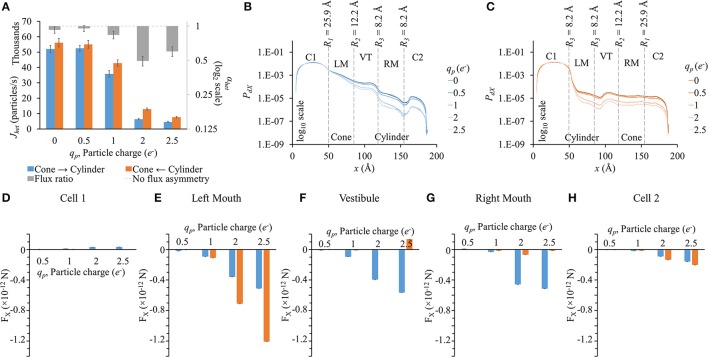
Role of particle charge on flux asymmetry in heterotypic pores. Simulation results in heterotypic pore with profile 25.9-12.2-8.2-8.2 with constant concentration gradient, 2 mV transjunctional voltage and rp = 4.9 Å. (A) Particle fluxes decreased with increasing particle charge. Flux ratio (gray bars) also rose up to qp = 2e−. (B,C) The PdX profiles were similar in shape but scaled down for high particle charge. (D–H) FX variation patterns for different qp were similar in the different sections, but the differences between the 2 directions were magnified with increasing qp. (D) FX magnitudes in cell 1 were marginal compared to FX in other sections. (E) In the left mouth, FX was negative in cylinder to cone direction and larger in magnitude. (F–G) In the vestibule and right mouth, FX were larger in the cone to cylinder direction. (H) FX in cell 2 were small and differences amongst the two directions were marginal.